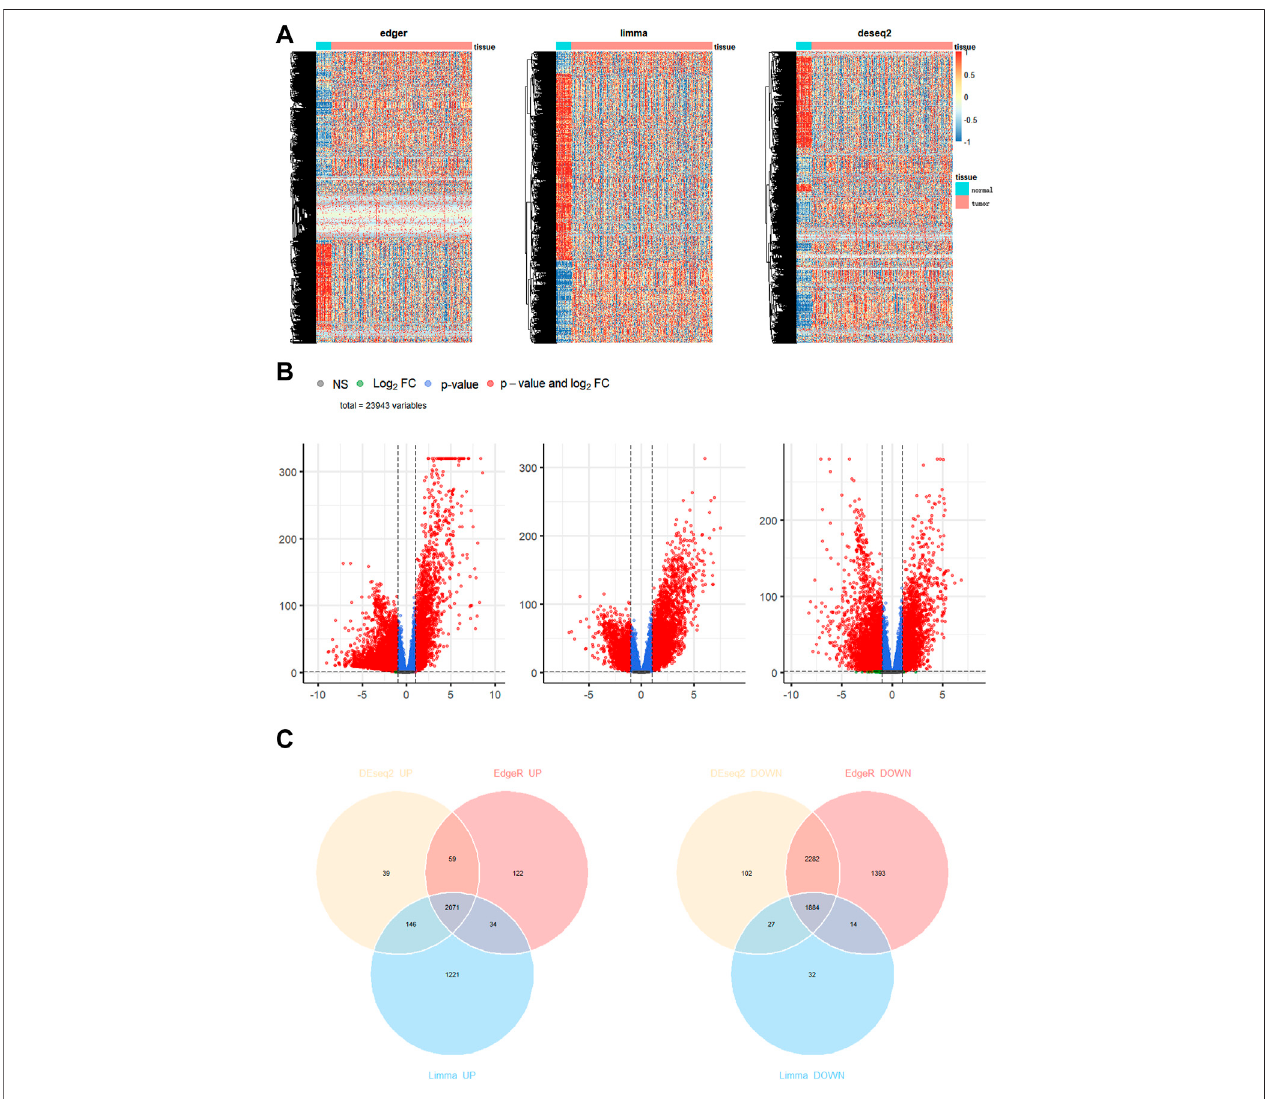
FIGURE 1 | Identi fi cation of differentially expressed genes in breast cancer. (A) Heatmap (B) volcano map (C) Venn diagram to compare the results of 3 R packages “ DESeq2 ” , “ edgeR ” , and “ limma ” .